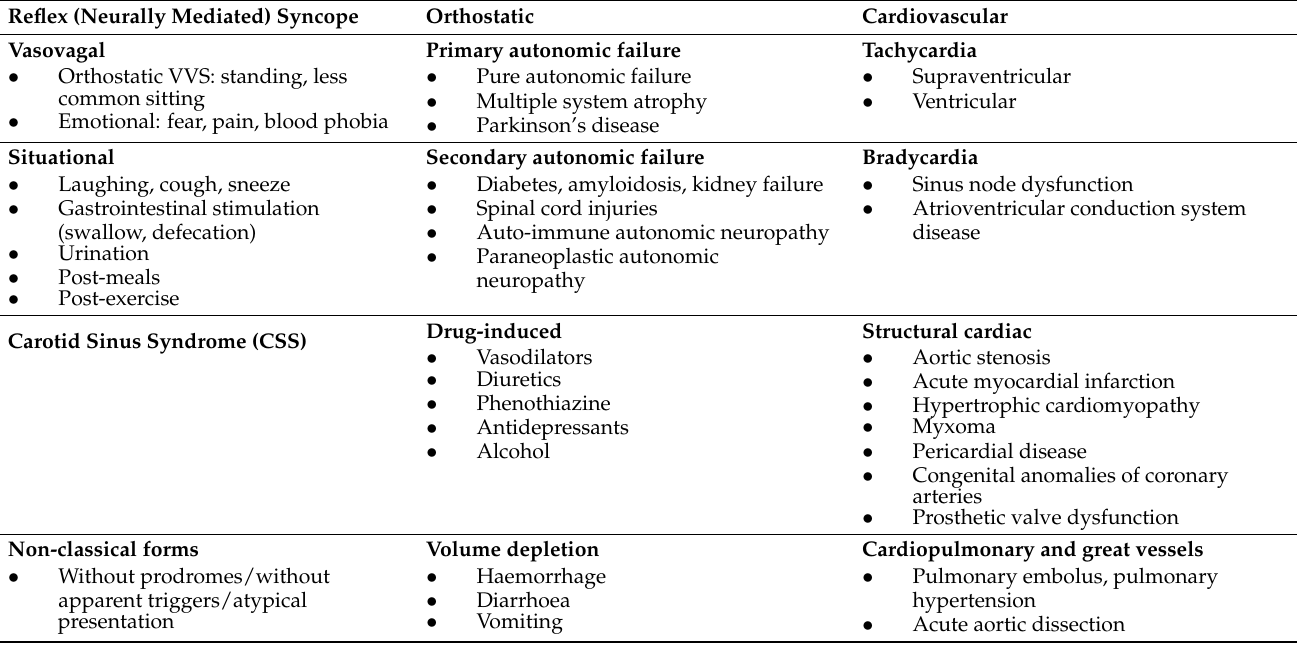
Table 1. Etiological classification of unexplained syncope